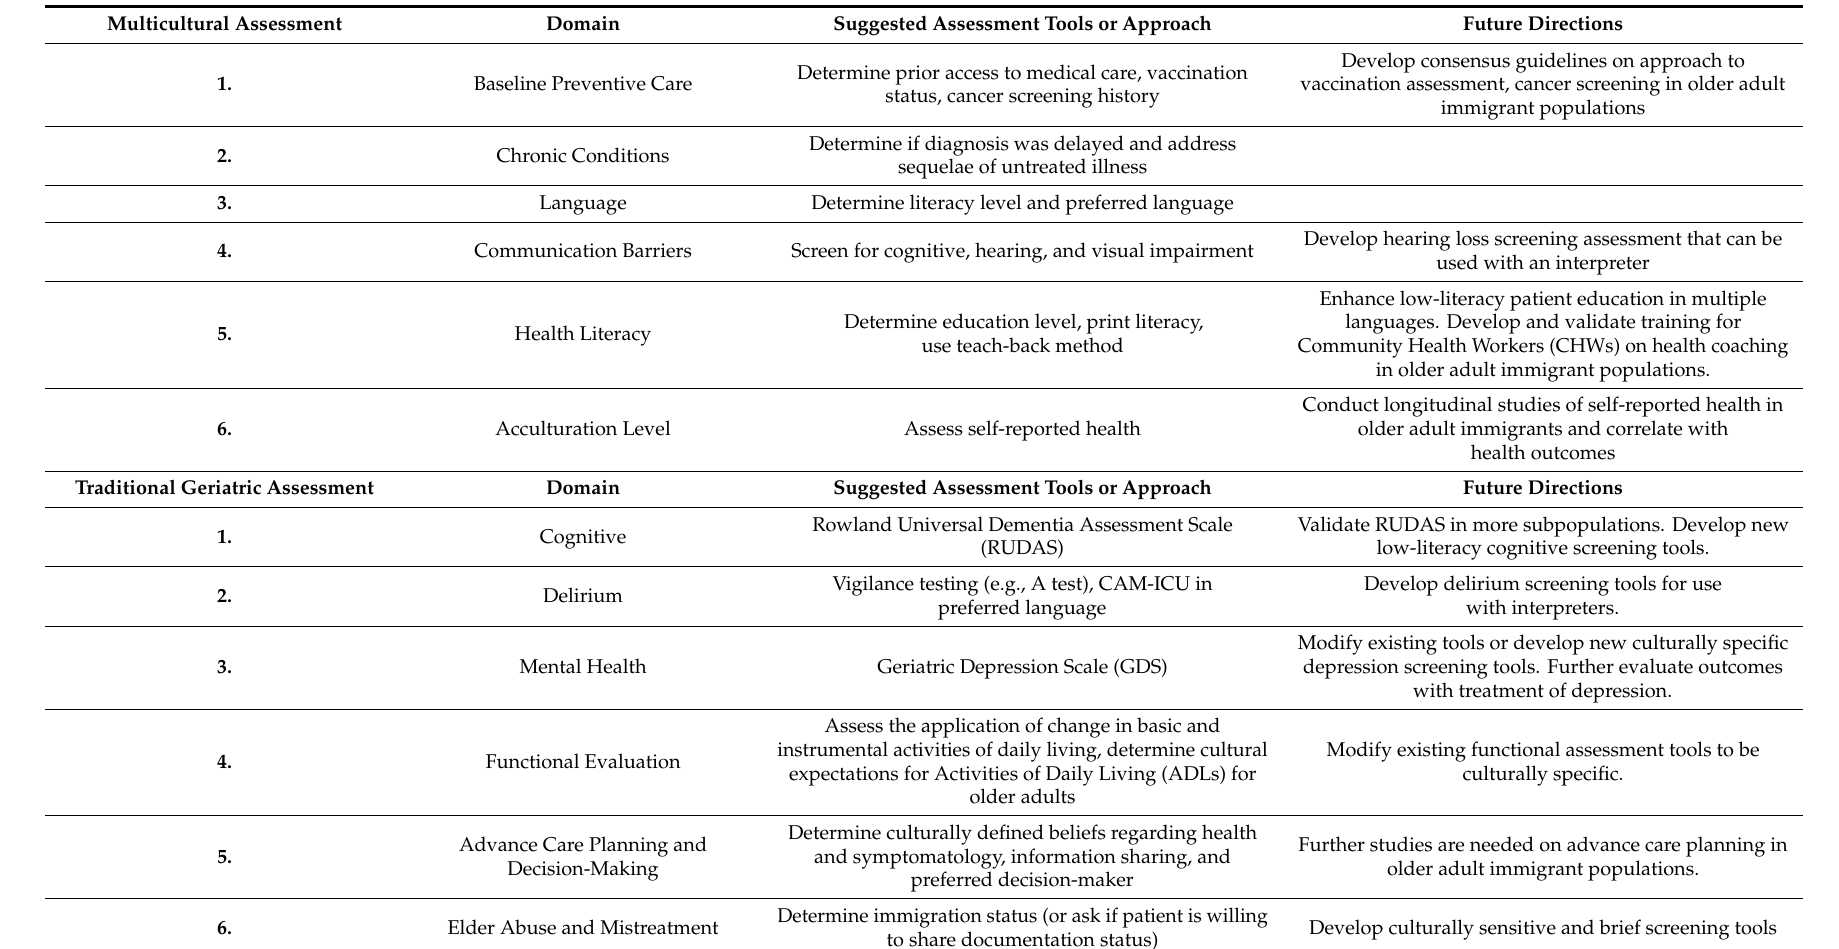
Table 1. Elements of a Multicultural Geriatric